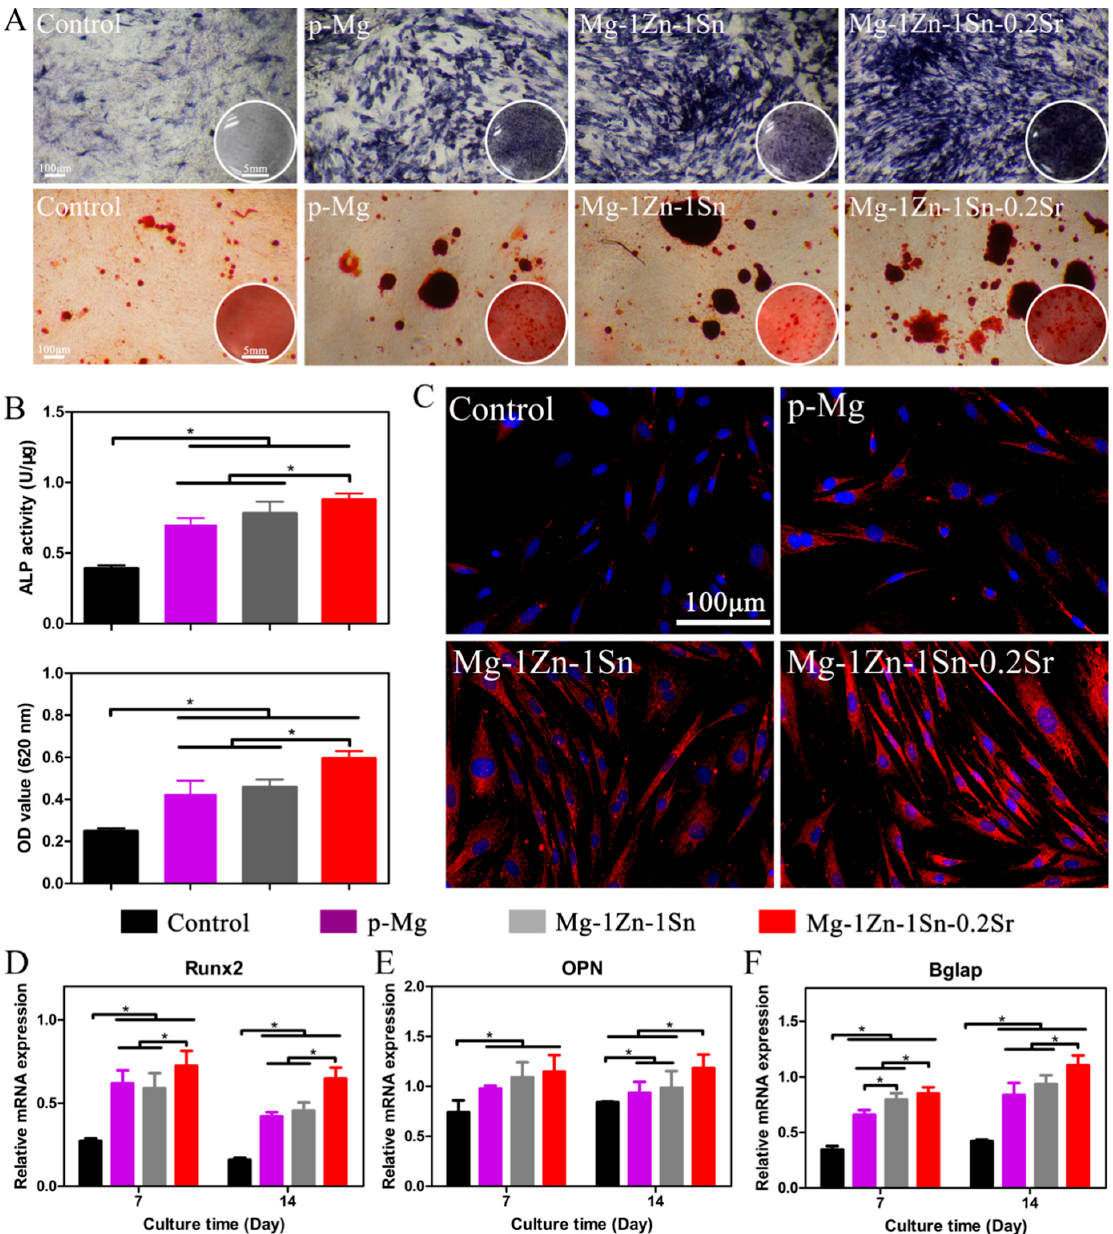
Figure 9. ( A ) Images of ALP activity and matrix mineralization, and ( B ) corresponding quantitative analysis. ( C ) Immunofluorescent staining of the expression of COL-I protein after osteogenic induction for 14 days. Osteogenesis-related genes Runx2 ( D ), OPN ( E ) and Bglap ( F ) expression in MC3T3-E1 cells after osteogenic induction for 7 and 14 days. Values are mean ± SD. * p < 0.05.